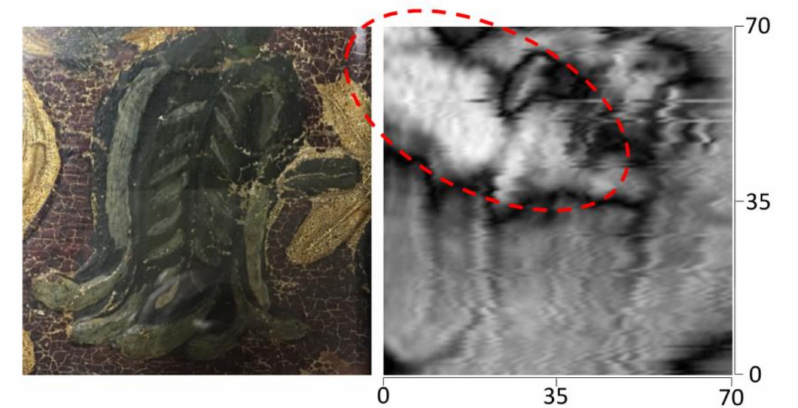
Figure 30. Visible image of a detail of leather wallpaper and the corresponding THz image.